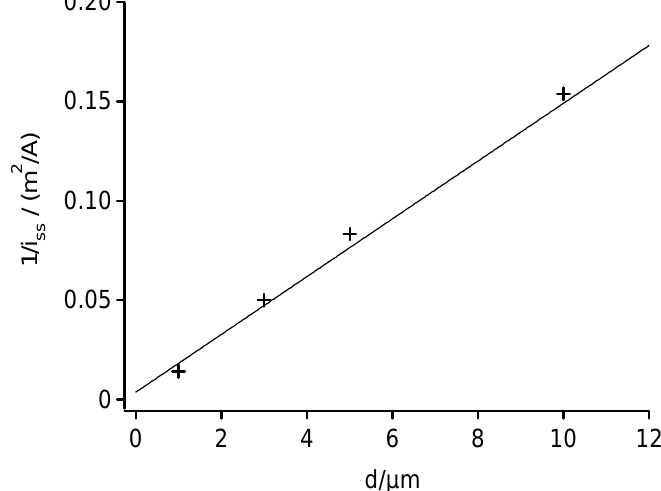
Figure 3. A plot of the inverse steady-state current density, 1/i d. Data used to construct the plot were from Figure 2. The straight line was calculated by using equation (1) and the experimental parameters of the cyclic voltammograms of Figure 2 (D = 7.2*10 -6 cm 2 s -1